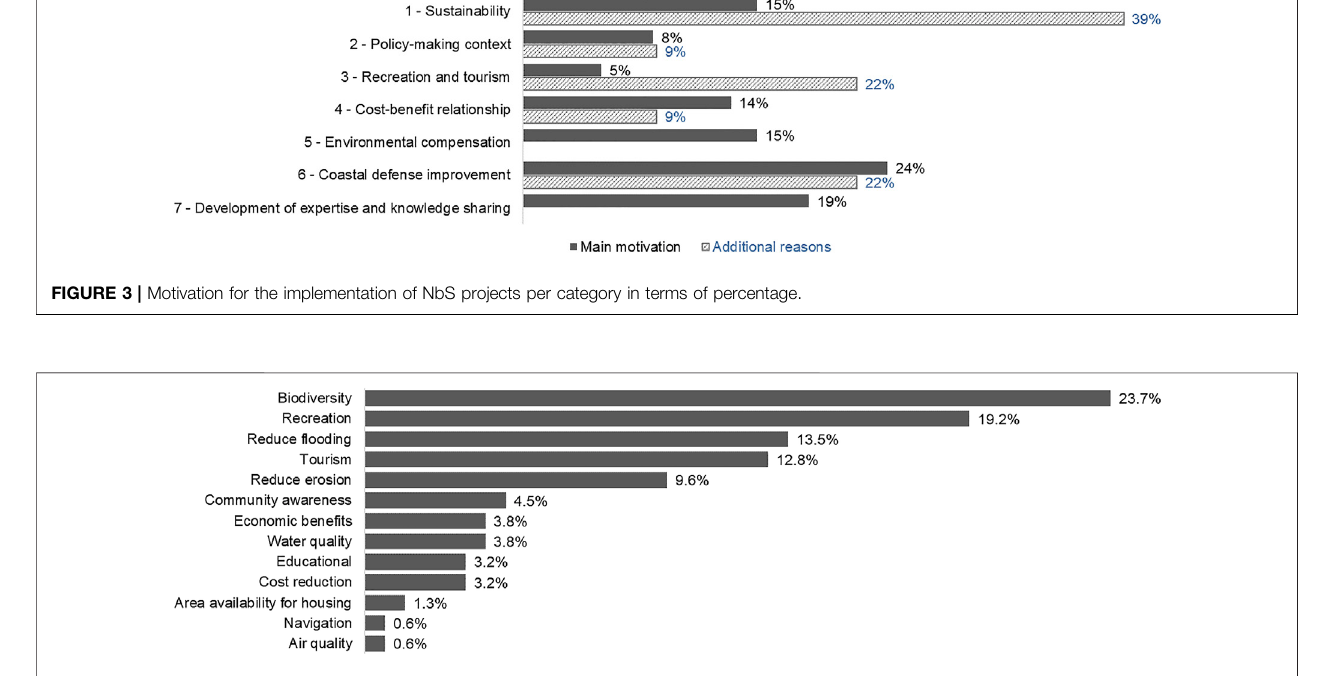
FIGURE 4 | Frequency of co-bene fi ts reported, per